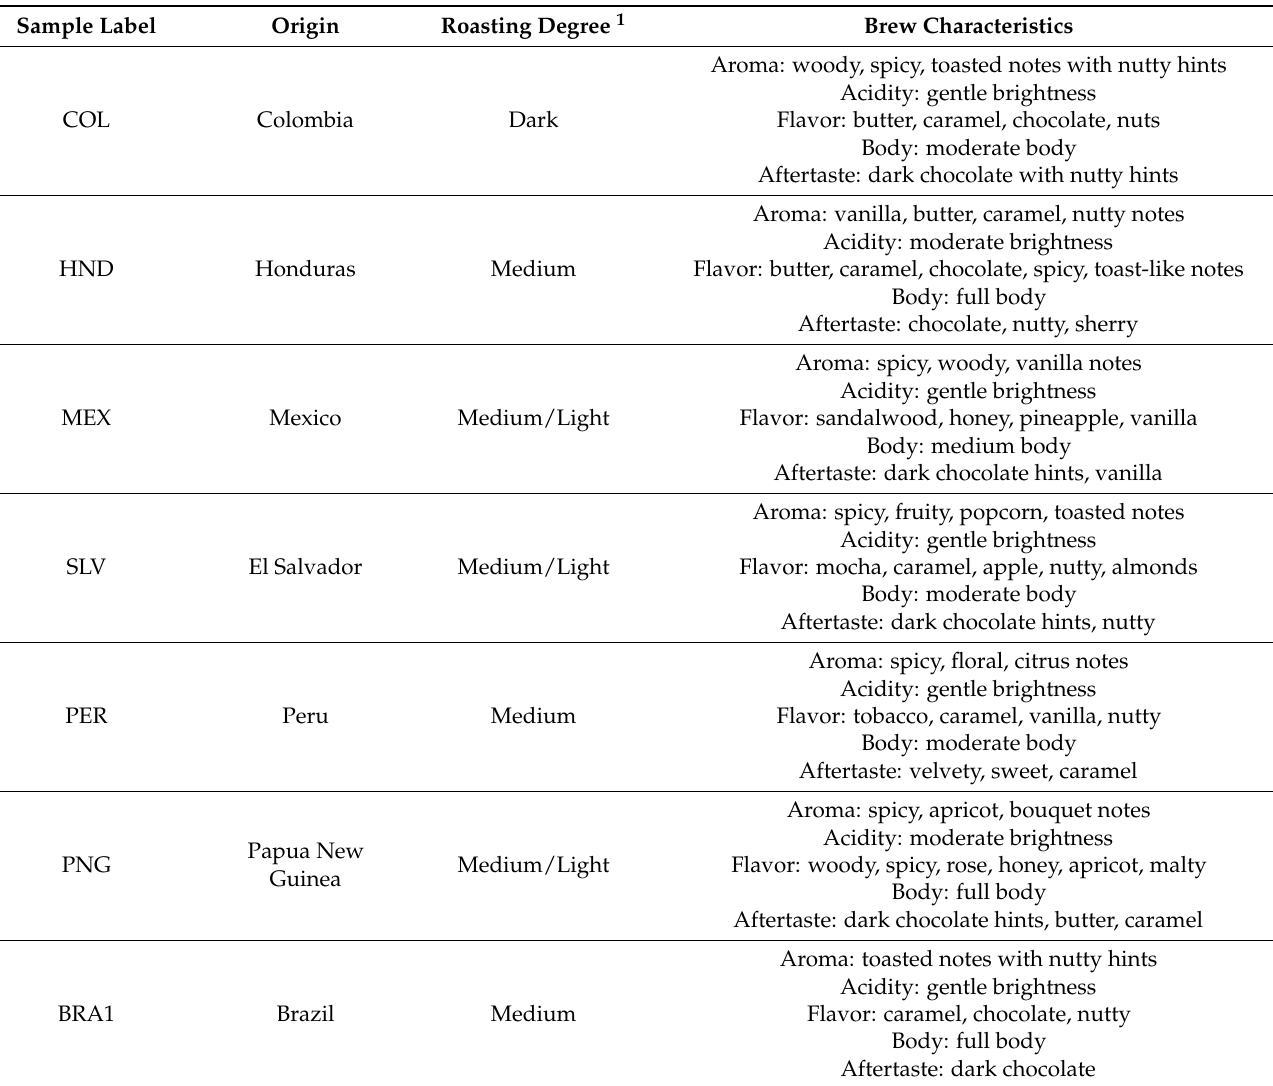
Table 1. Description of the studied coffee